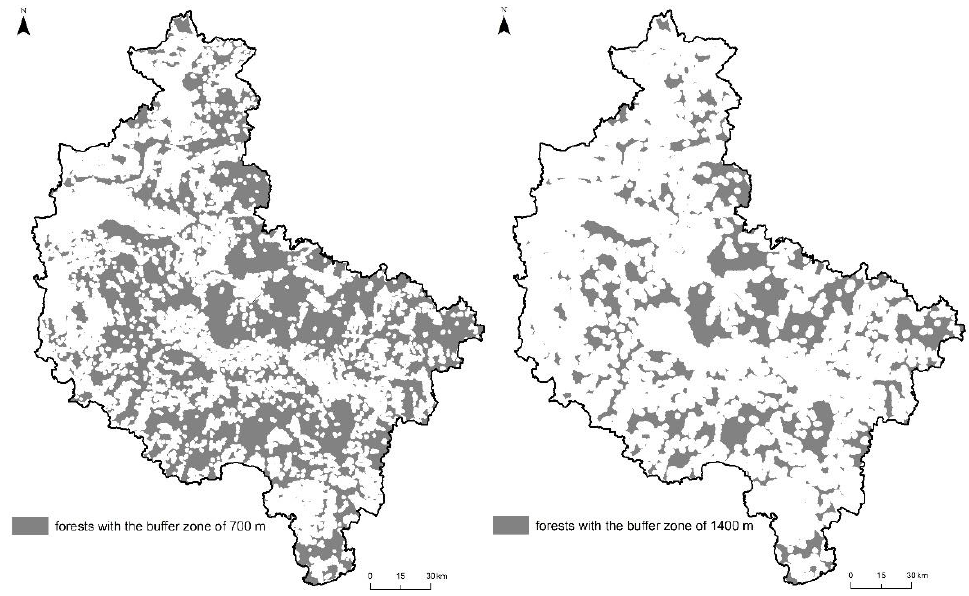
Figure 7. Area available for wind energy development—forest areas with the buffer zones of 700 m and 1400 m in the Greater Poland Voivodeship (own calculations).